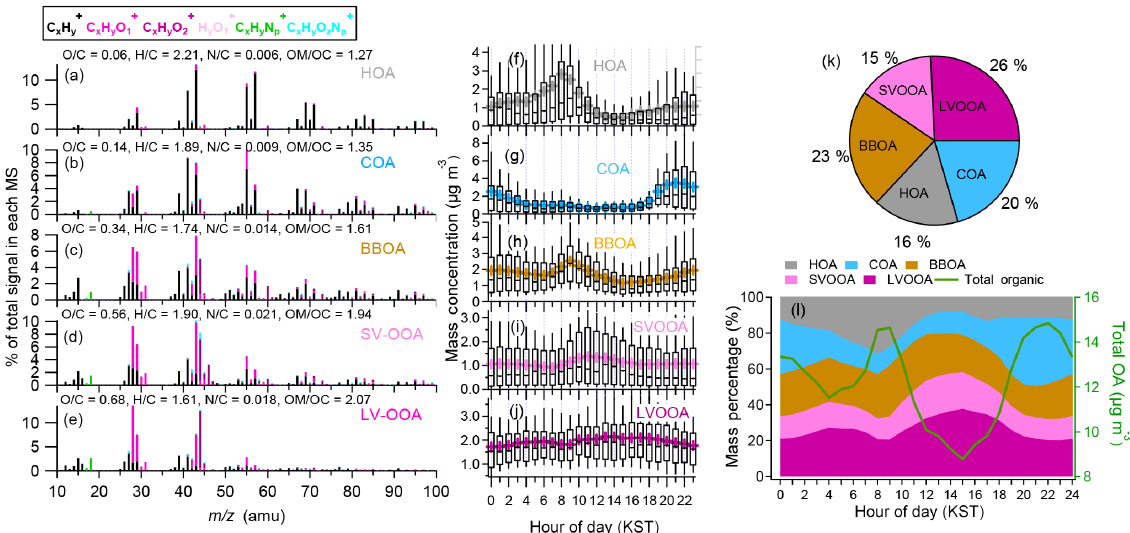
Figure 10. Overview of the results from PMF analysis, including high-resolution mass spectra of the (a) hydrocarbon-like organic aerosol (HOA), (b) cooking OA (COA), (c) biomass burning OA (BBOA), (d) semivolatile oxygenated OA (SV-OOA), and (e) low-volatility oxy- genated OA (LV-OOA) colored by different ion families. (f–i) Average diurnal profiles of each of the OA factors (the 90th and 10th percentiles are denoted by the whiskers above and below the boxes. The 75th and 25th percentiles are denoted by the top and bottom of the boxes. The median values are denoted by the horizontal line within the box, and the mean values are denoted by the colored markers). (k) Compositional pie chart of the average fractional contribution of each of the OA factors to the total OA over the campaign; (l) average diurnal mass fractional contribution of each of the OA factors to the total OA diurnal mass and the total OA mass